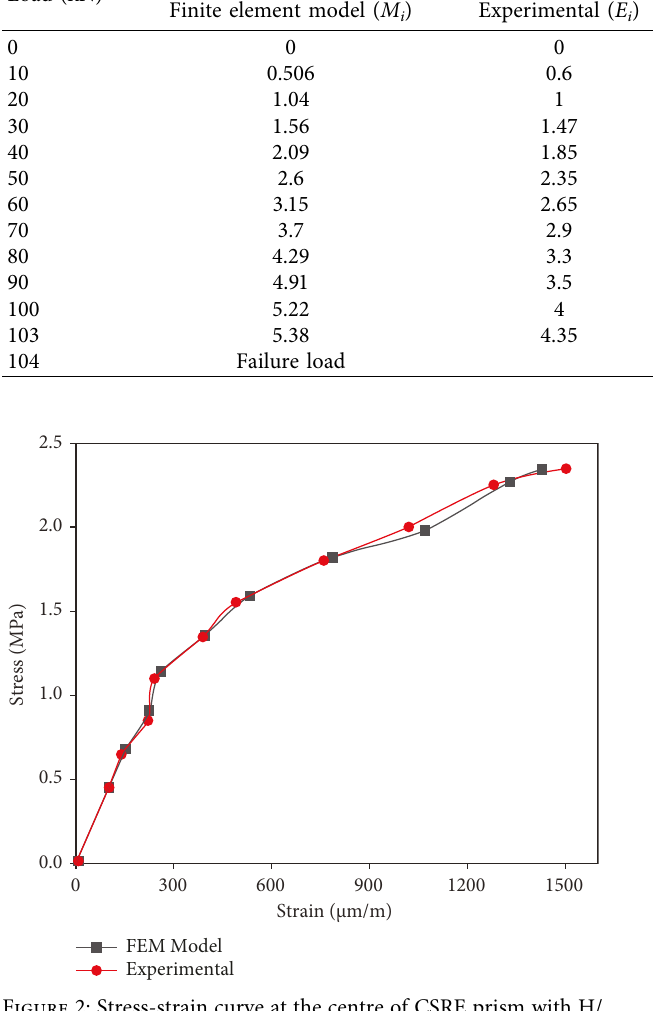
Figure 2: Stress-strain curve at the centre of CSRE prism with H/ T � 3 under concentric loading.